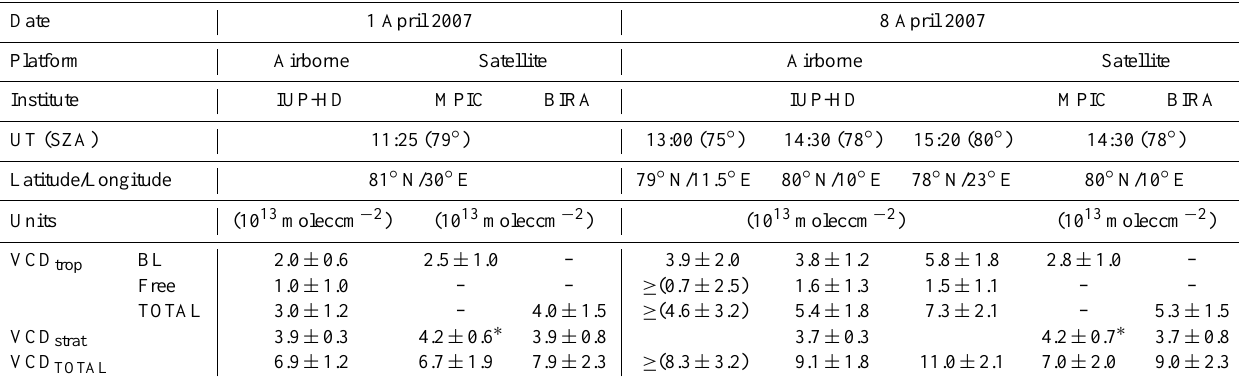
Table 1. BrO VCD comparison between airborne and satellite measurements during the Arctic spring (2007). Note that VCD strat retrieved by the MPIC team may contain free tropospheric BrO (indicated as ∗ ). On the other hand, BrO columns inferred from balloon measurements performed in Kiruna (67.9 ◦ N, 21.1 ◦ E) on 23 March 2003 and on 24 March 2004 are given as airborne VCD strat for 1 April 2007 and for 8 April 2007, respectively. Further details are given in Sect. 4. For information concerning the aircraft deployments of 1 and 8 April 2007, the reader is referred to Prados-Roman